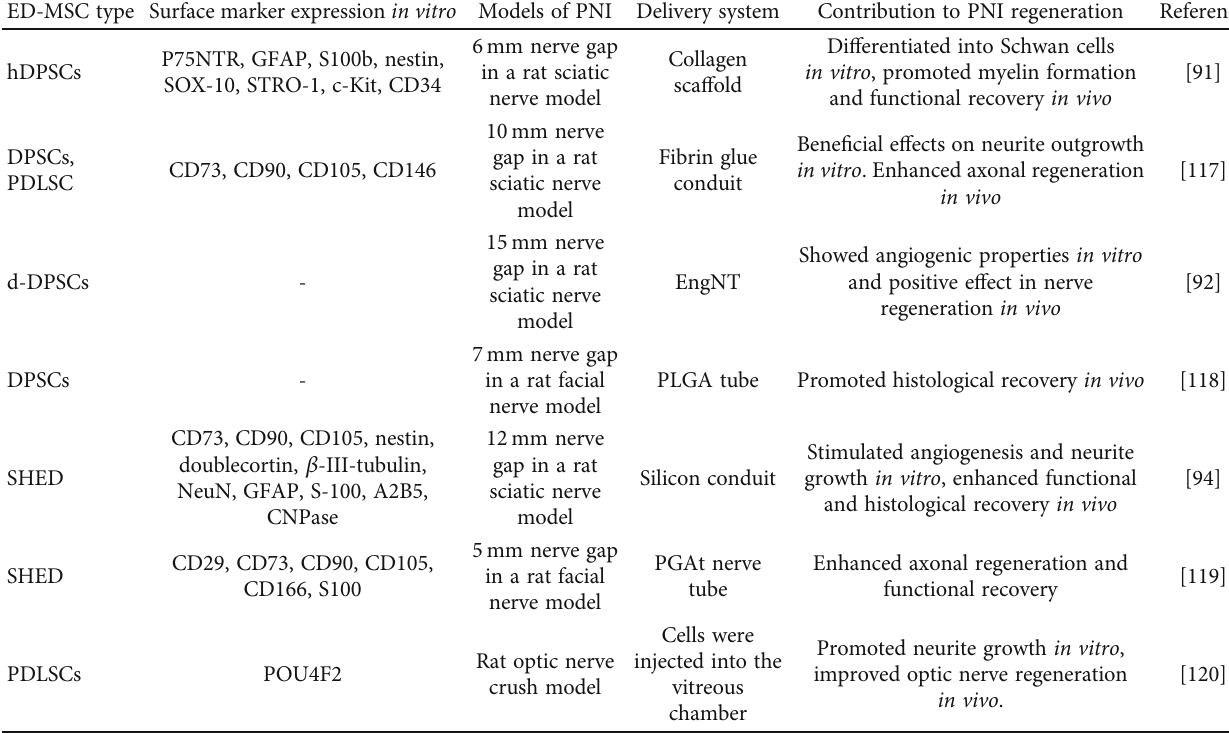
Table 4: E ff ect of di ff erent ED-MSCs types in PNI animal models.